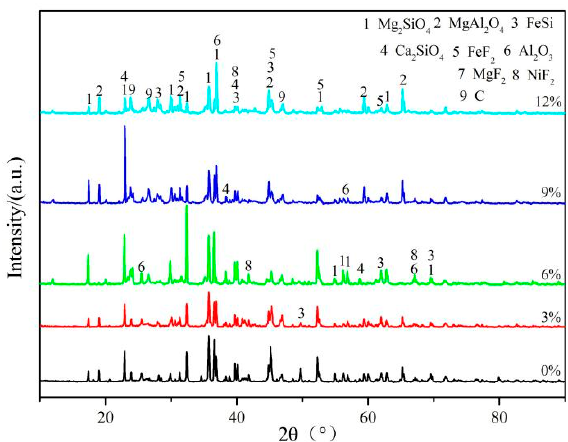
Figure 17. XRD patterns of the Fe–Ni-rich residue at 1723 K with 0–12% CaF 2 .